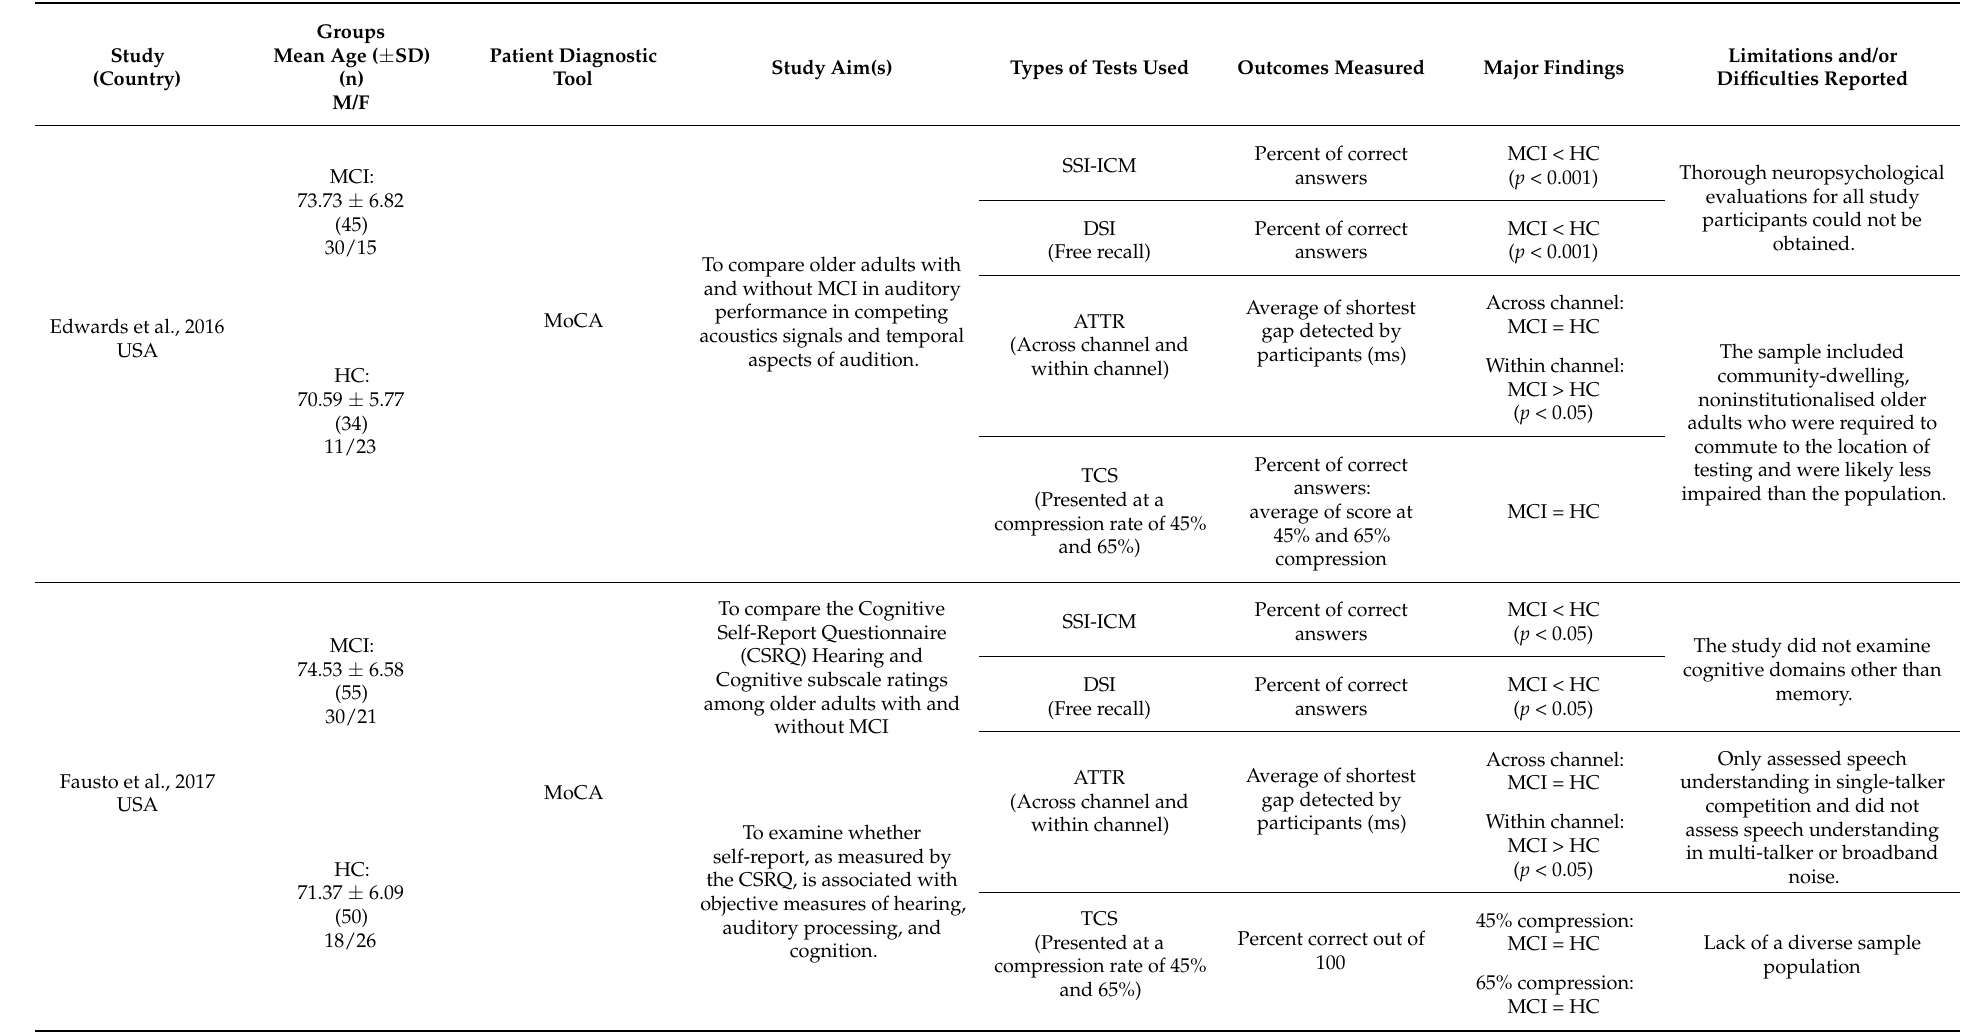
Table 1. Data extraction summary of central auditory assessment studies included in the systematic